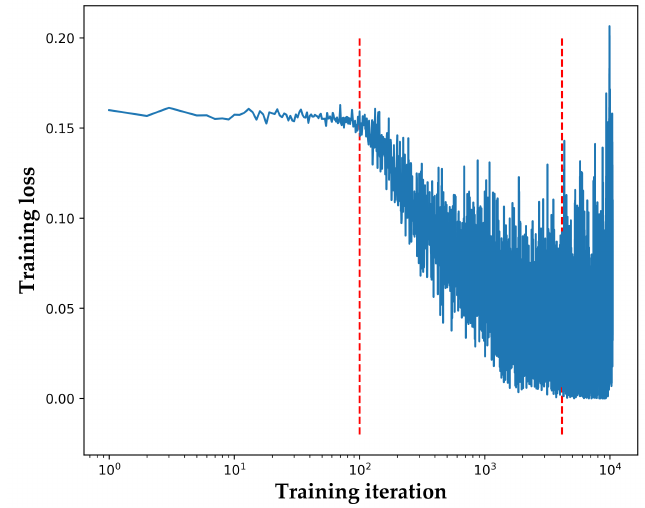
Figure 5. Relationship between network loss and training